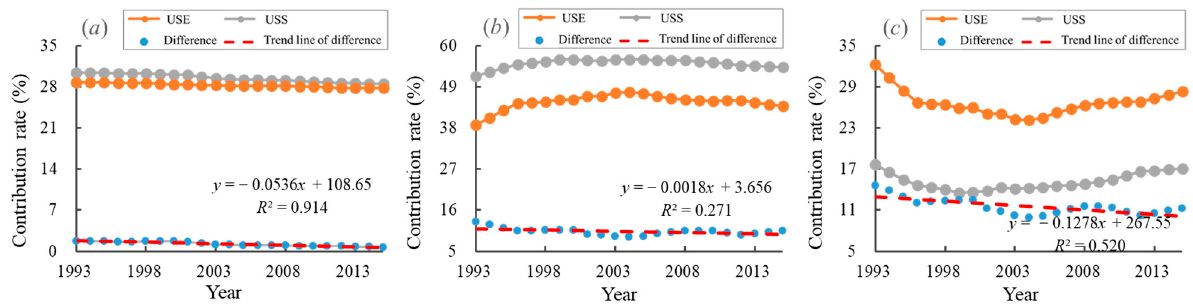
Figure 11. Differences between USS and USE contribution rates: ( a ) regional differences in contribution, ( b ) regional difference contribution, ( c ) ultra-variable density contribution. Note: USS is urban spatial expansion and USE is urban socioeconomic expansion.